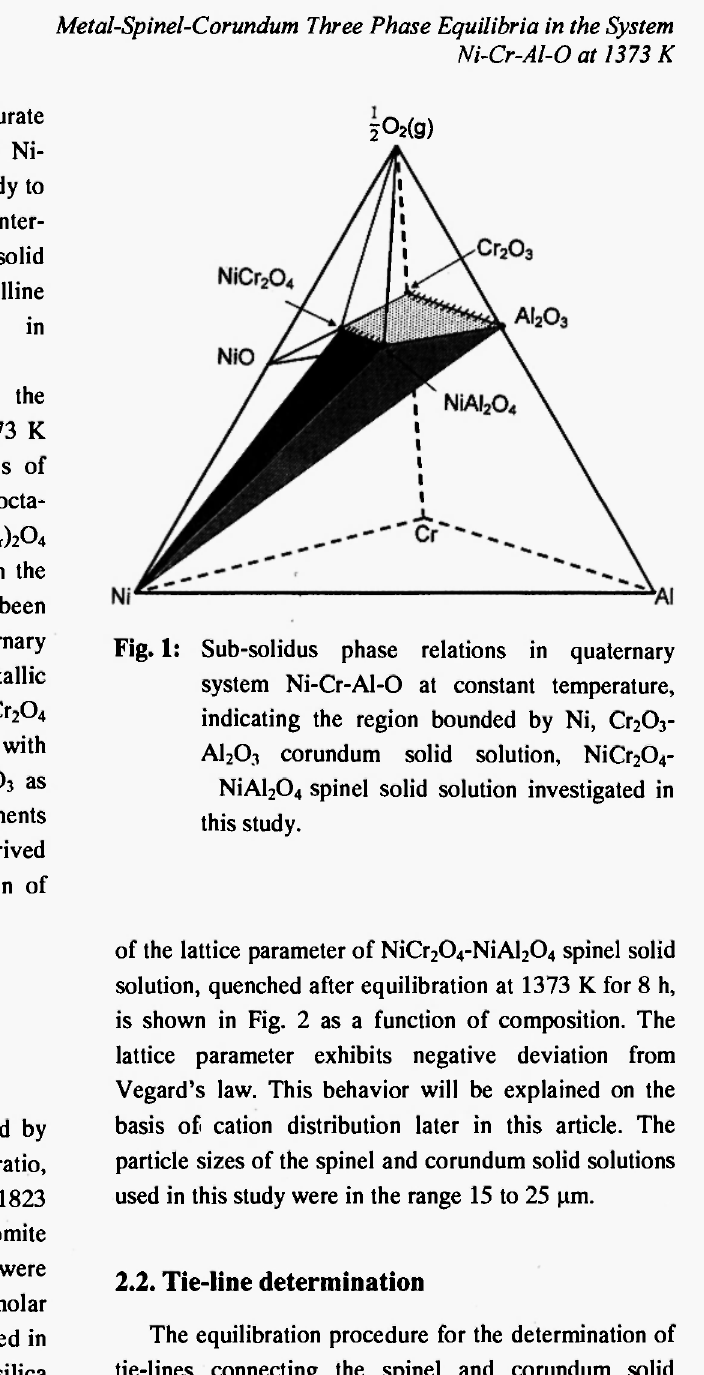
of the lattice parameter of NiCr 2 0 4 -NiAl 2 0 4 spinel solid solution, quenched after equilibration at 1373 Κ for 8